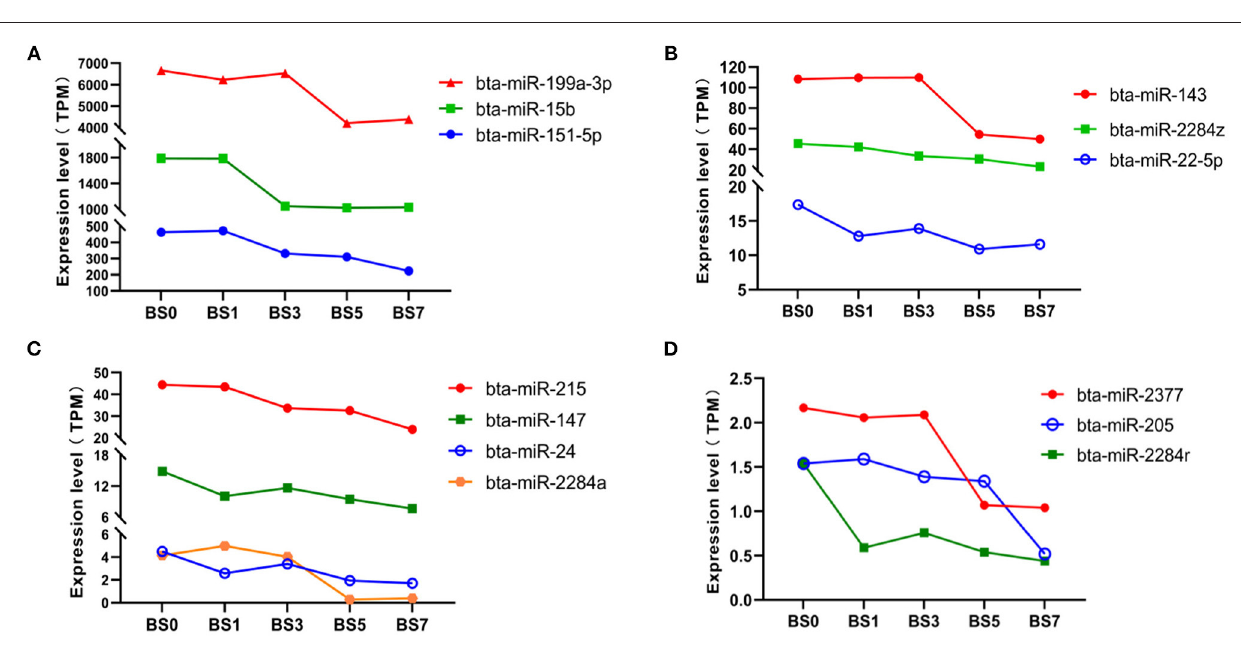
FIGURE 5 | Expression of miRNA with expression partially down-regulated at different induction times. (A) miRNA with highly abundant expression; (B,C) miRNA with medium abundant expression; and (D) miRNA with lowly abundant